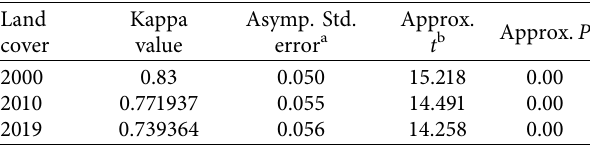
Table 3: Estimation of the kappa value. Table 4: Migration effect in land